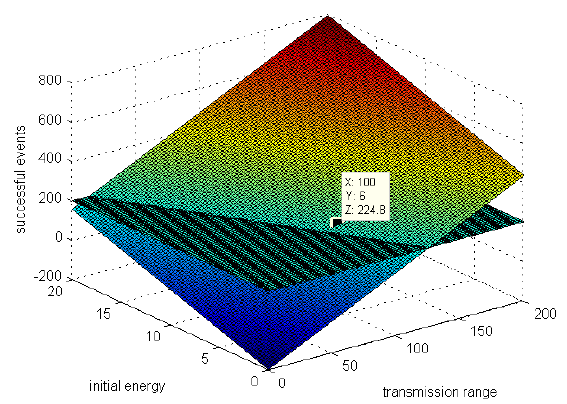
Fig. 14. Mean value for the number of successful events for EAST with neighborhood discovery as a function of the maximum transmission range and the node initial energy with an intersecting plane with the value 200 successful